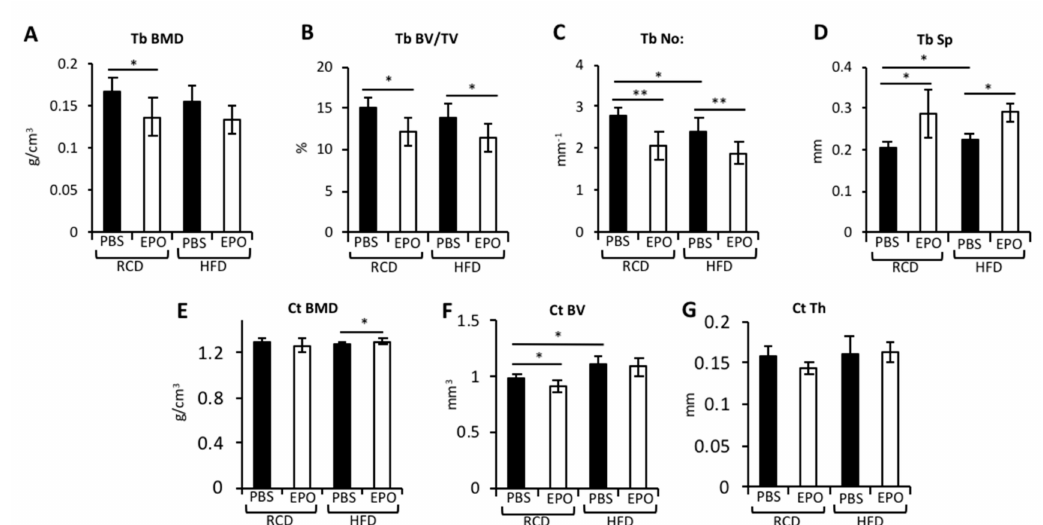
Figure 2. EPO administration in HFD-fed mice reduces trabecular bone volume and maintains